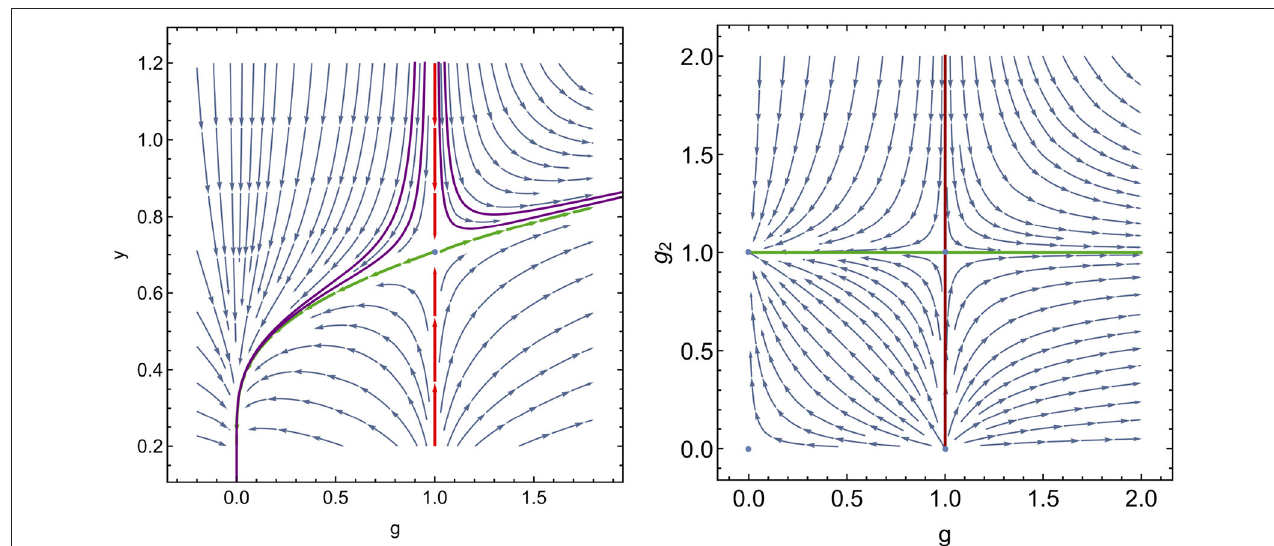
1, y 1 / √ 2 that has one UV attractive and one IR = = g 2 1, which is IR attractive in g 2 and where the = =